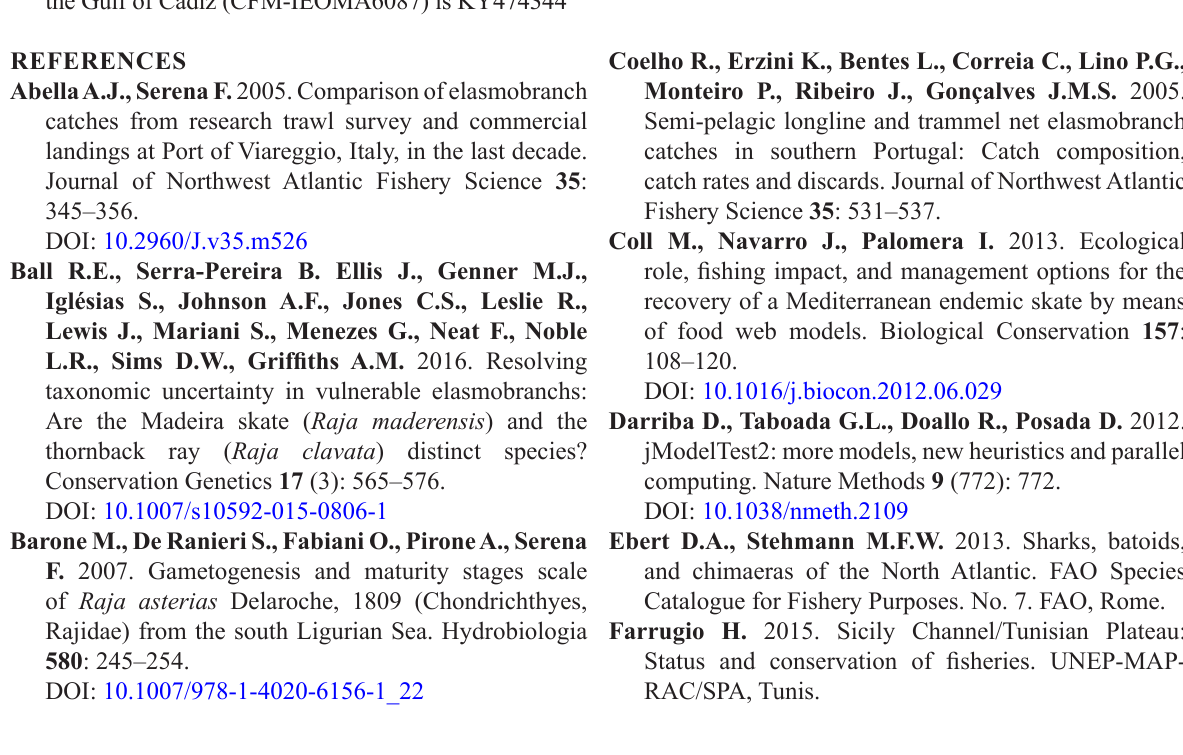
Fig. 3. Maximum likelihood tree based on the cytochrome c oxidase subunit I (COI) fragment of Raja species from Mediterranean and North-eastern Atlantic; The GenBank accession numbers are indicated next to species name and the sampling localities are shown between brackets; The GenBank accession number of the individual studied from the Gulf of Cádiz (CFM-IEOMA6087) is